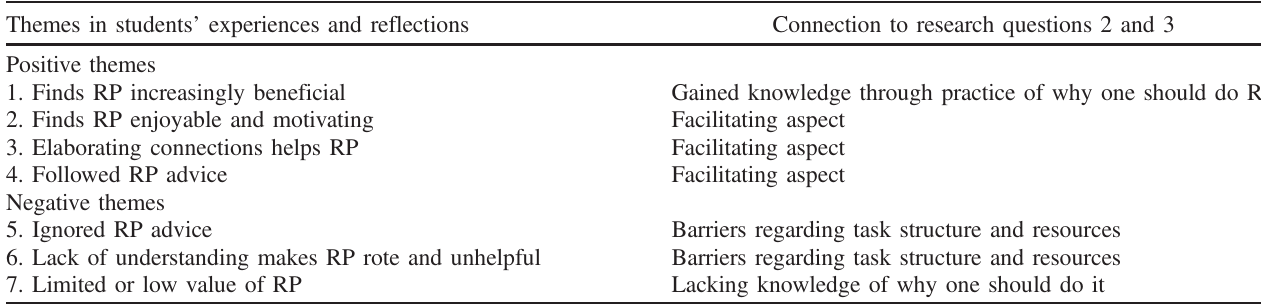
TABLE II. Themes from students ’ experiences and reflections on retrieval practice (RP). Themes in students ’ experiences and